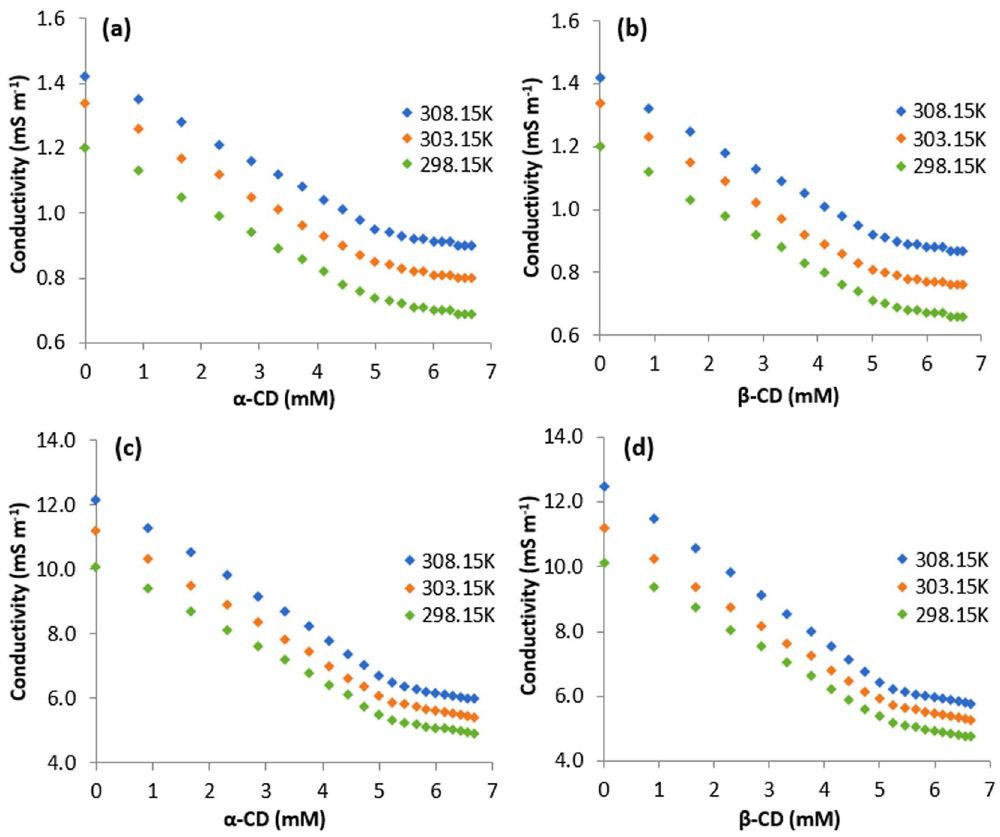
Figure 7. (a , b , c , d) Variations in the conductivity of aqueous SNP with increasing concentration of (a) α -CD, (b) β -CD and the variations in the same of aqueous PEH with increasing concentration of (c) α -CD, (d) β -CD at 298.15 to 308.15